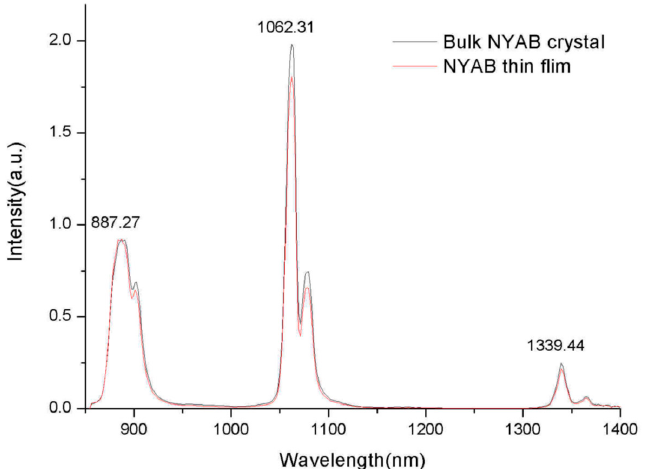
bulk Nd:YAB sample.